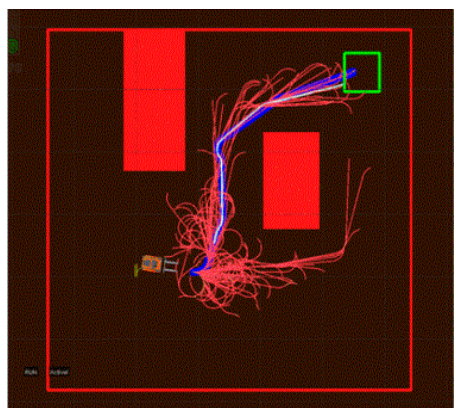
Figure 4. Illustration of RRT.